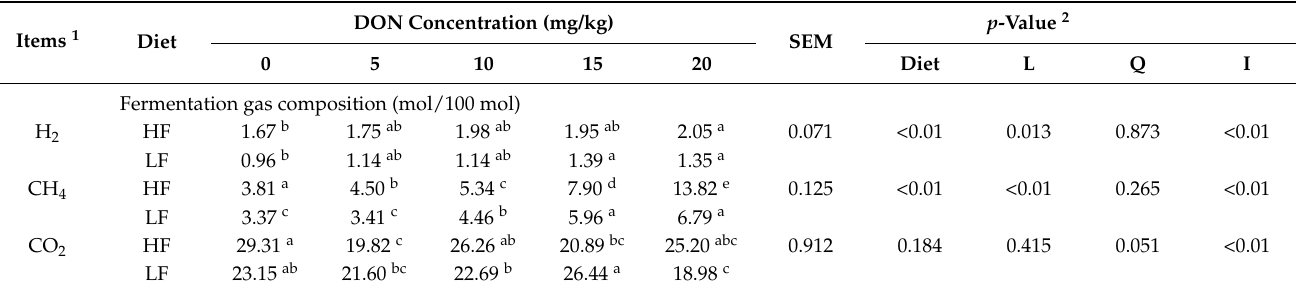
Table 6. Effect of DON concentration (mg/kg) in culture fluids on fermentation gas composition during 48 h